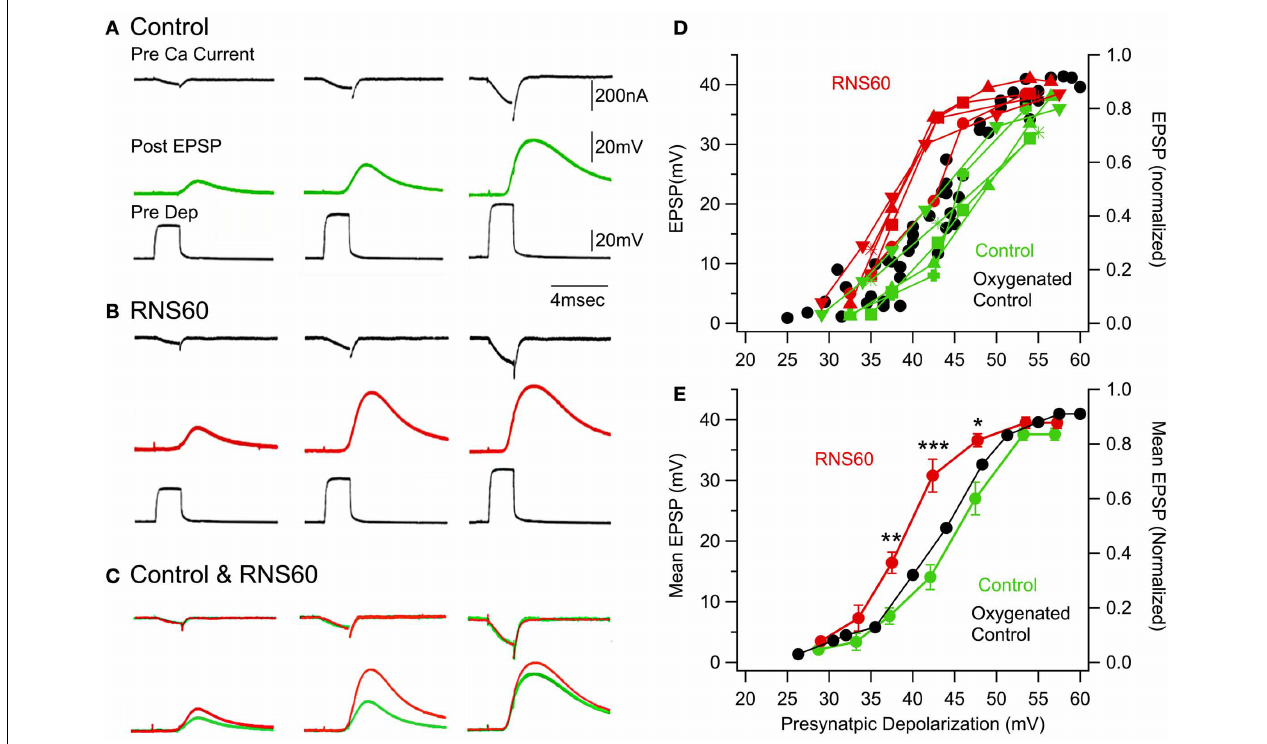
FIGURE 4 | Voltage clamp study indicating that RNS60 increases transmitter release without modifying calcium current or its relationship with transmitter release. (A) Set of traces recorded in Control ASW show the amplitude and time course of the presynaptic calcium current (black), the amplitude and time course of the postsynaptic response (green) elicited by the rapid voltage clamp step shown in the third trace (Pre Dep, black). (B) Set of traces recorded in RNS60 ASW with the same amplitude depolarizing pulses as in the control set; EPSPs are red. (C) Superposition of calcium currents (upper traces) and EPSPs (lower trace) from panel (A) for control (green) and panel (B) for RNS60 (red) ASW demonstrates that there was no change in the time course or amplitude of the presynaptic